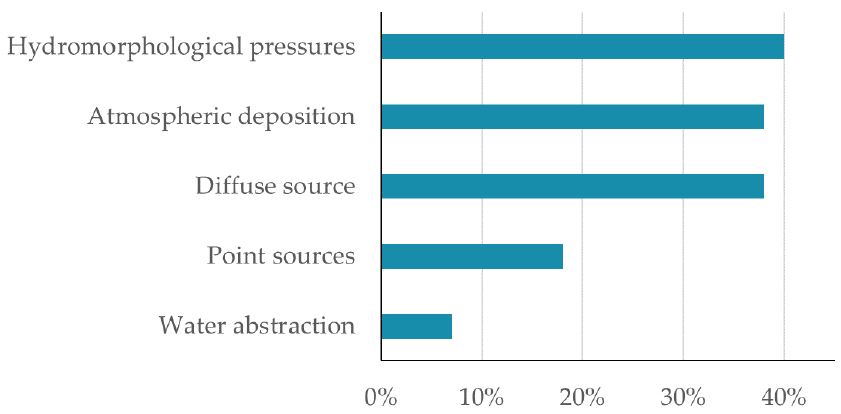
Figure 3. The main significant pressures on EU surface water bodies .